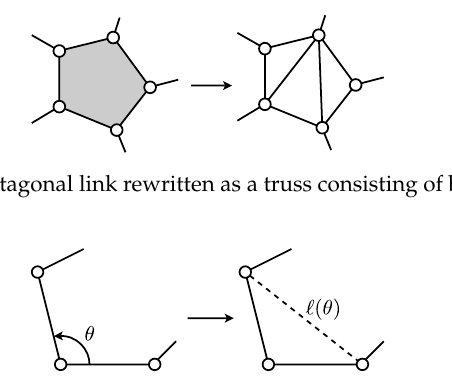
Figure 2. An active pair rewritten as an additional binary link in length (cid:96) ( θ )